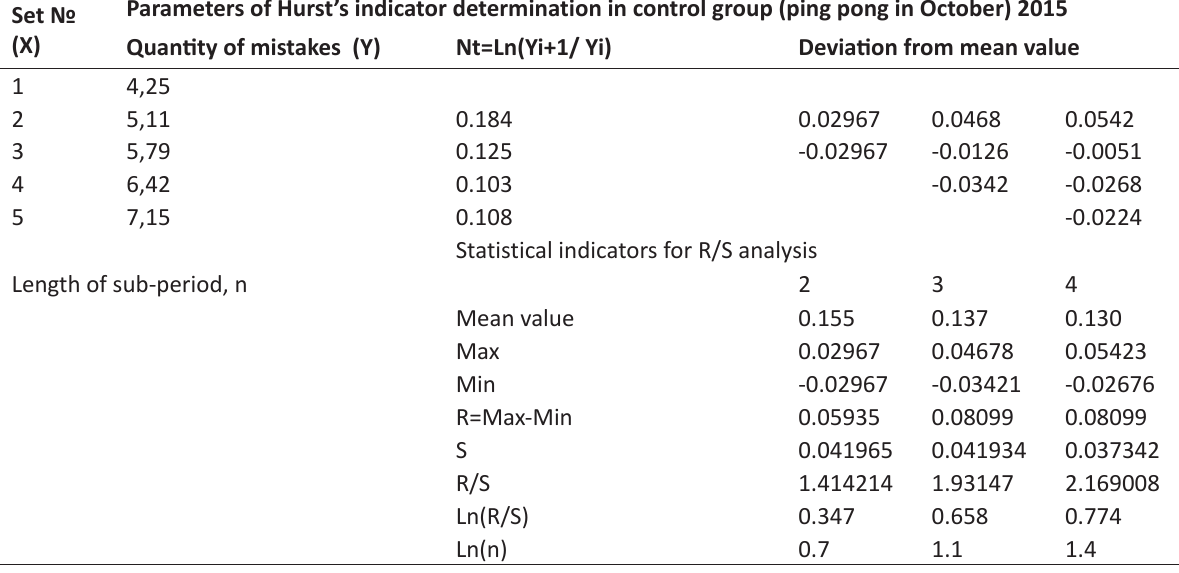
Table 3. Parameters of Hurst’s indicator determination in control group (ping pong in October) 2015 Set № (X)